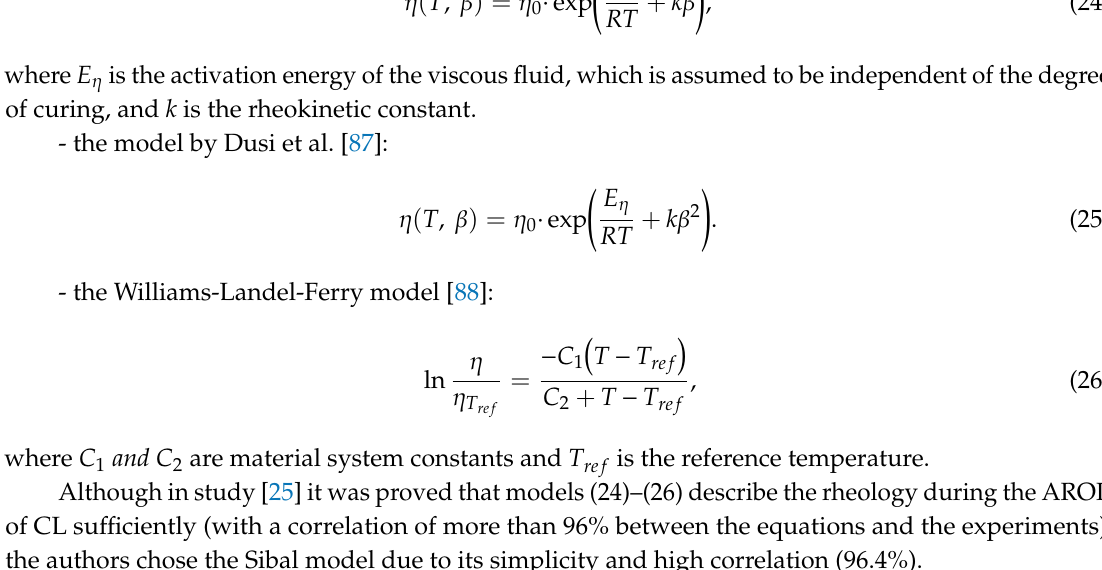
Table 2. Recent advances in the experimental investigation of the rheokinetic behavior of CL during AROP. Year Experimental Setup Description Monomer Equipment: Rheometrics Dynamic Mechanical Analyzer, RMS-800. Rheometer platens : disposable aluminum parallel plates (D50 mm, 0.5 mm gap). The reactive mixture is delivered into the rheometer platen gap by simultaneous injection of two 1997 streams (one containing CL with the initiator, and the other containing CL with the activator) through a static mixture. Shear mode: sinusoidal oscillatory shear rate ω = 100 rad s − 1 . Sample surface to volume ratio: 40 cm − 1 Equipment: strain-controlled rheometer ARES. Rheometer platens : cone and plate (D40 mm, 0.06 mm gap). 2013 The reactive mixture is premixed and quickly introduced with a syringe into the gap between the preheated cone and plate. Equipment: parallel plate rheometer MCR-301 Rheometer platens : upper plate – disposable aluminum plate D50 mm and D25 mm; lower plate – aluminum cup D75 mm; 0.5 mm gap. The reactive mixture is premixed and quickly poured into the rheometer cup.